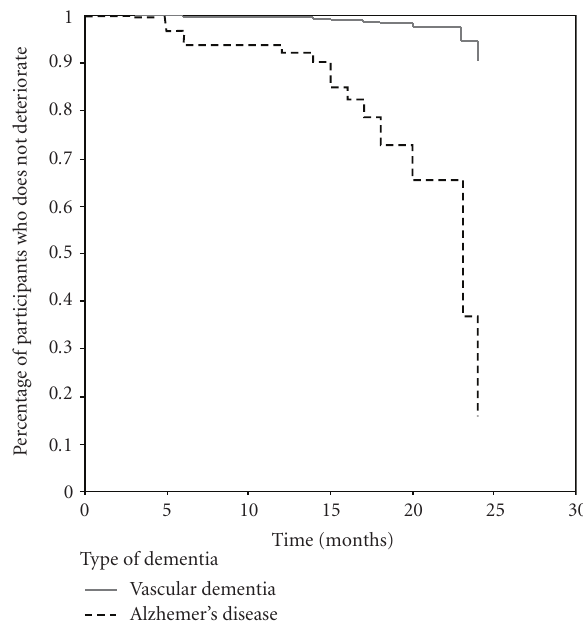
Figure 2: Survival Rate in Relation to Severity of Dementia (CDR scale): with vascular risk factor in the